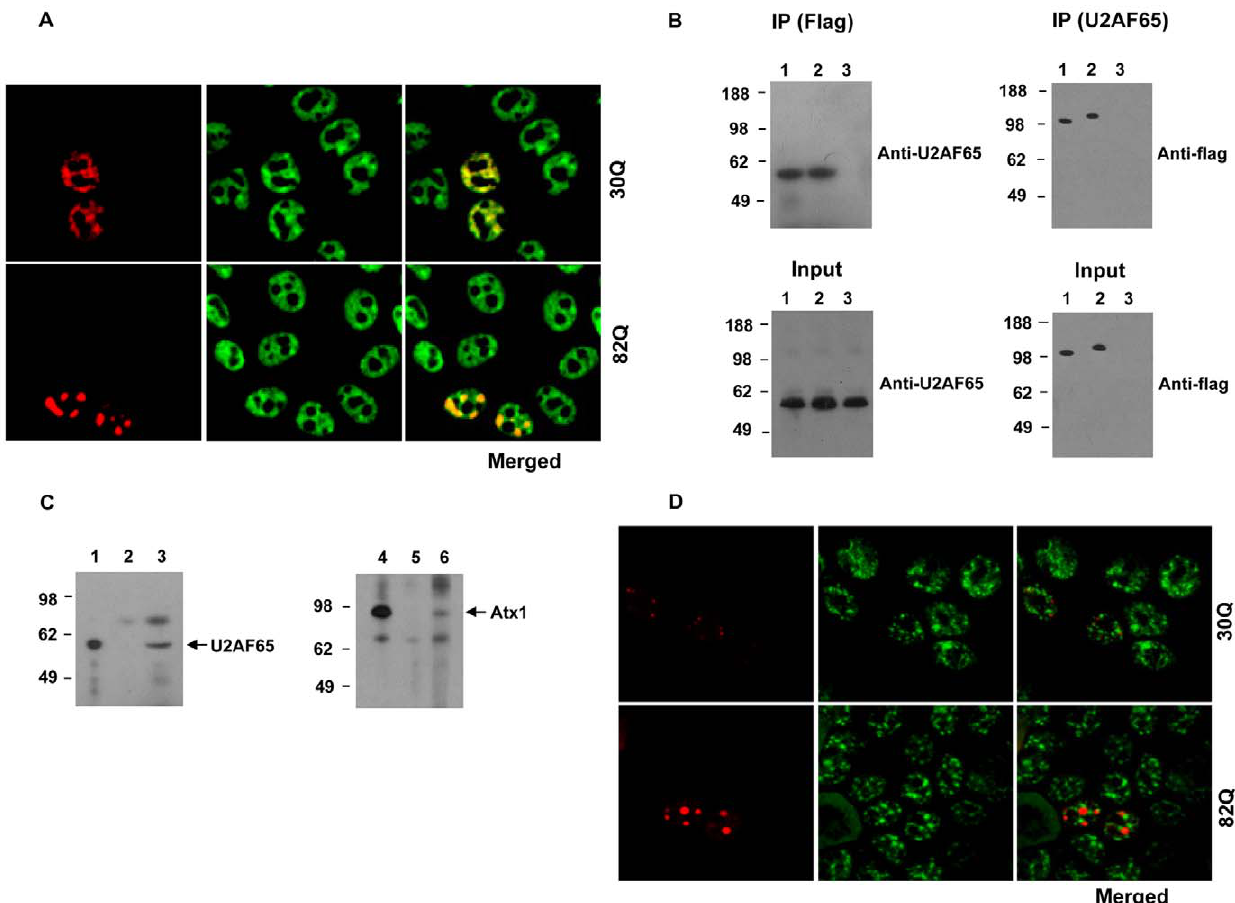
Figure 3. Interaction of Atx1 with U2AF65. A. Co-localization of Atx1 with endogenous U2AF65 in HeLa cells transfected with RFP-tagged Atx1 constructs and analysed by confocal microscopy. Non-expanded (30Q) or expanded Atx1 (82Q) (red) co-localized with endogenous U2AF65 (green), as evidenced by the merged images. B. Interaction of Atx1 with endogenous U2AF65 in HeLa cells. HeLa cells were transfected with flag tagged non- expanded Atx1 (lane 1), expanded Atx1 (lane 2) or empty pCMV constructs (lane 3). Lysates from these cells were immunoprecipitated with anti-flag or anti-U2AF65 antibodies. Pelleted samples were analysed by western blot using anti-U2AF65 and anti-flag antibodies (IP). 5% of the lysates from transfected cells were analysed by western blot using respective antibodies (Input). Molecular weight markers are shown on the left. C. Association of Atx1 with U2AF65 in cerebellum extracts from mouse brain. The extracts were subjected to immunoprecipitation with anti-Atx1 antibodies, anti- U2AF65 antibodies or control anti-flag antibodies. 2.5% of pelleted complexes from anti-U2AF65 IP (lane 1) and 25% from anti-flag IP (lane 2) and anti-Atx1 IP (lane 3) were subjected to PAGE and Western blot analysis using anti- U2AF65 antibodies. 2.5% of pelleted complexes from anti-Atx1 IP (lane 4) and 25% from anti-flag IP (lane 5) and anti-U2AF65 IP (lane 6) were subjected to PAGE and Western blot analysis using anti-Atx1 antibodies. D. Atx1 does not localize with a nuclear speckle marker. HeLa cells were transfected with RFP-tagged non-expanded (30Q) or expanded (82Q) Atx1 (red). Cells were fixed, permeabilized and stained with anti-SC-35 antibodies followed by FITC conjugated secondary antibodies (green). Merged images indicate that neither forms of Atx1 co-localize to the speckles defined by SC-35.